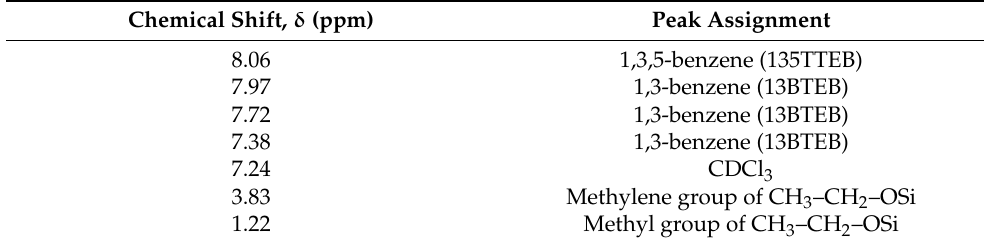
Table 1. 1 H-NMR (600 MHz, chloroform-d) chemical shift of two 135TTEB precursor solutions; one extracted at 100 to 110 ◦ C and another one at ≥ 130 ◦ C, where deuterated chloroform (CDCl 3 ) was used as the solvent.